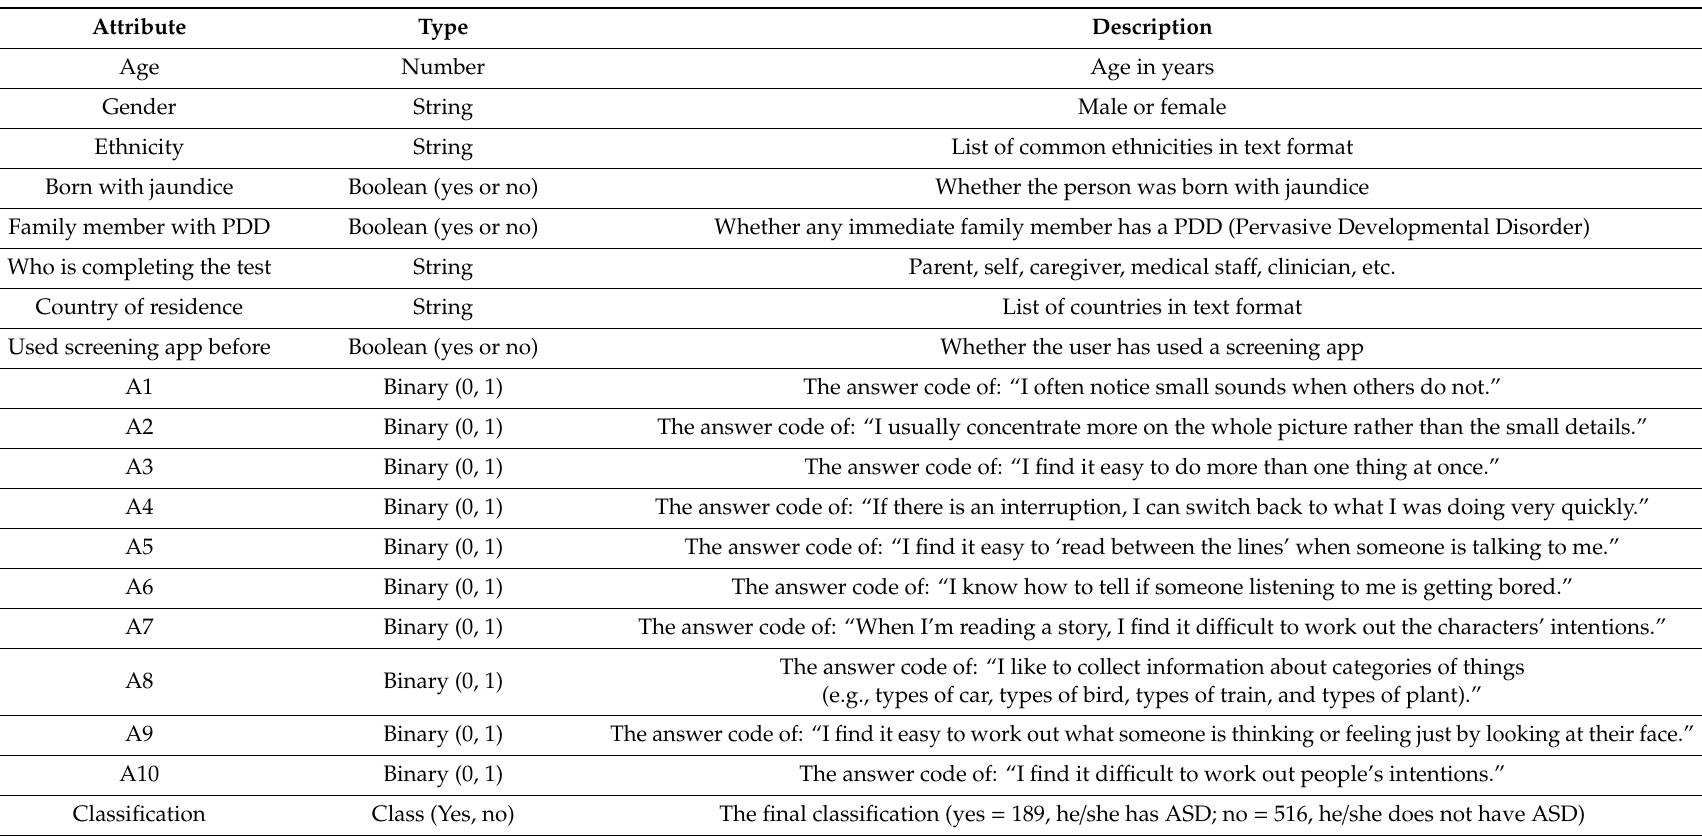
Table 1. List of attributes and their descriptions for Autism Spectrum Disorder (ASD) screening data for adults, adolescents, and